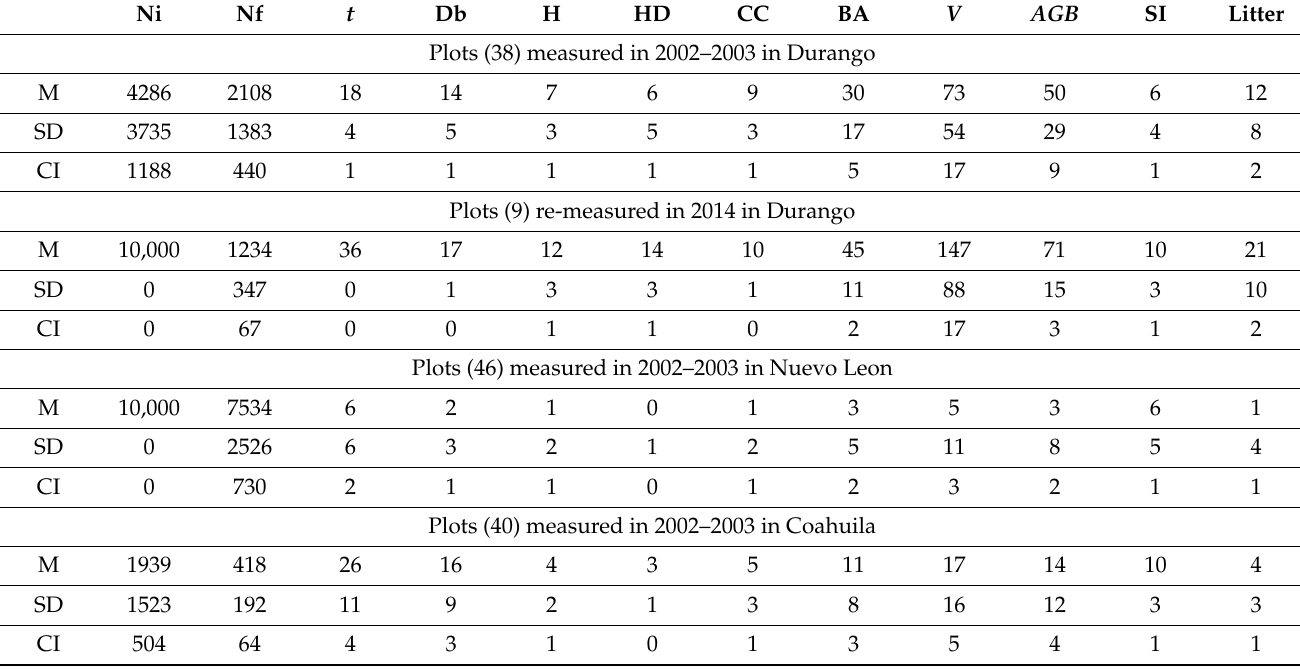
Table 1. Statistics of measurements for plots used to fit and validate litter stock equations for northern Mexico forest